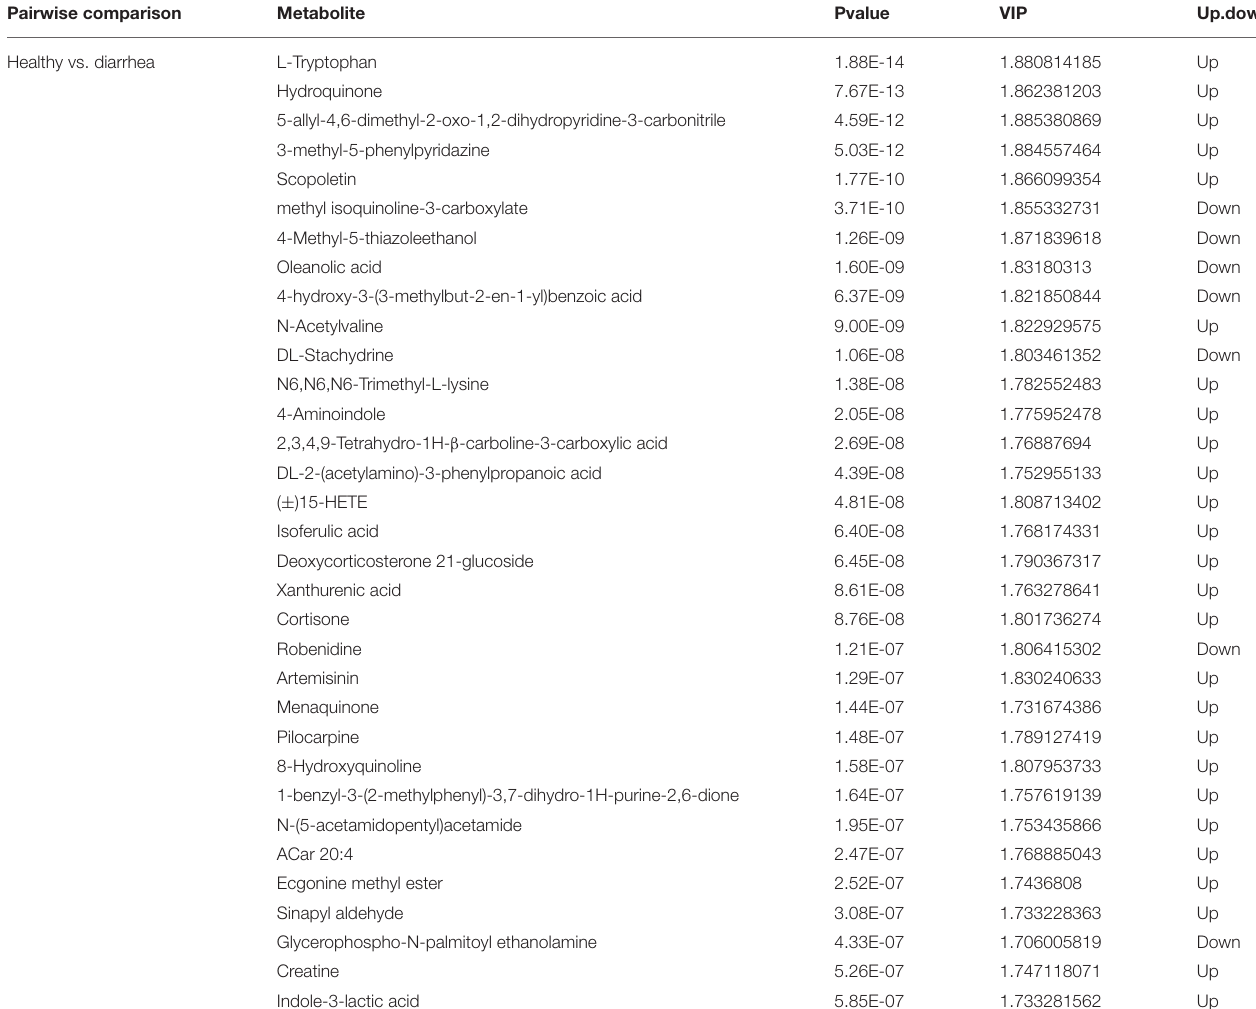
TABLE 2 | Significant metabolites among the two groups. Pairwise comparison Metabolite Pvalue VIP Up.down Healthy vs. diarrhea